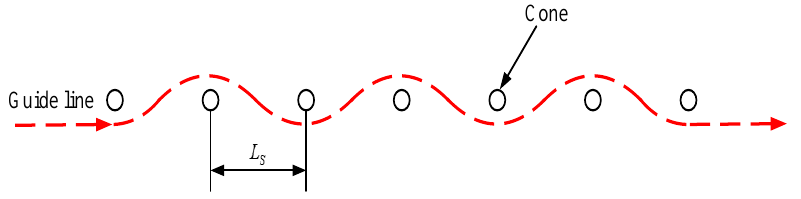
Figure 5. Slalom test situation of the schematic diagram.